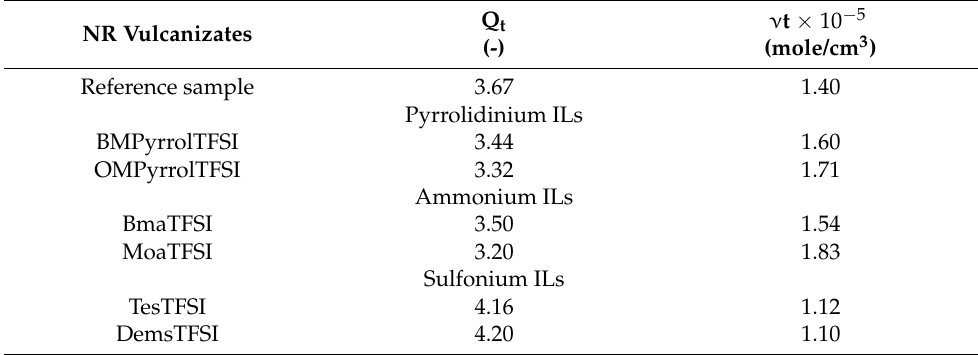
Table 6. Equilibrium swelling in toluene (Q t ) and crosslink density ( ν t ) of NR vulcanizates